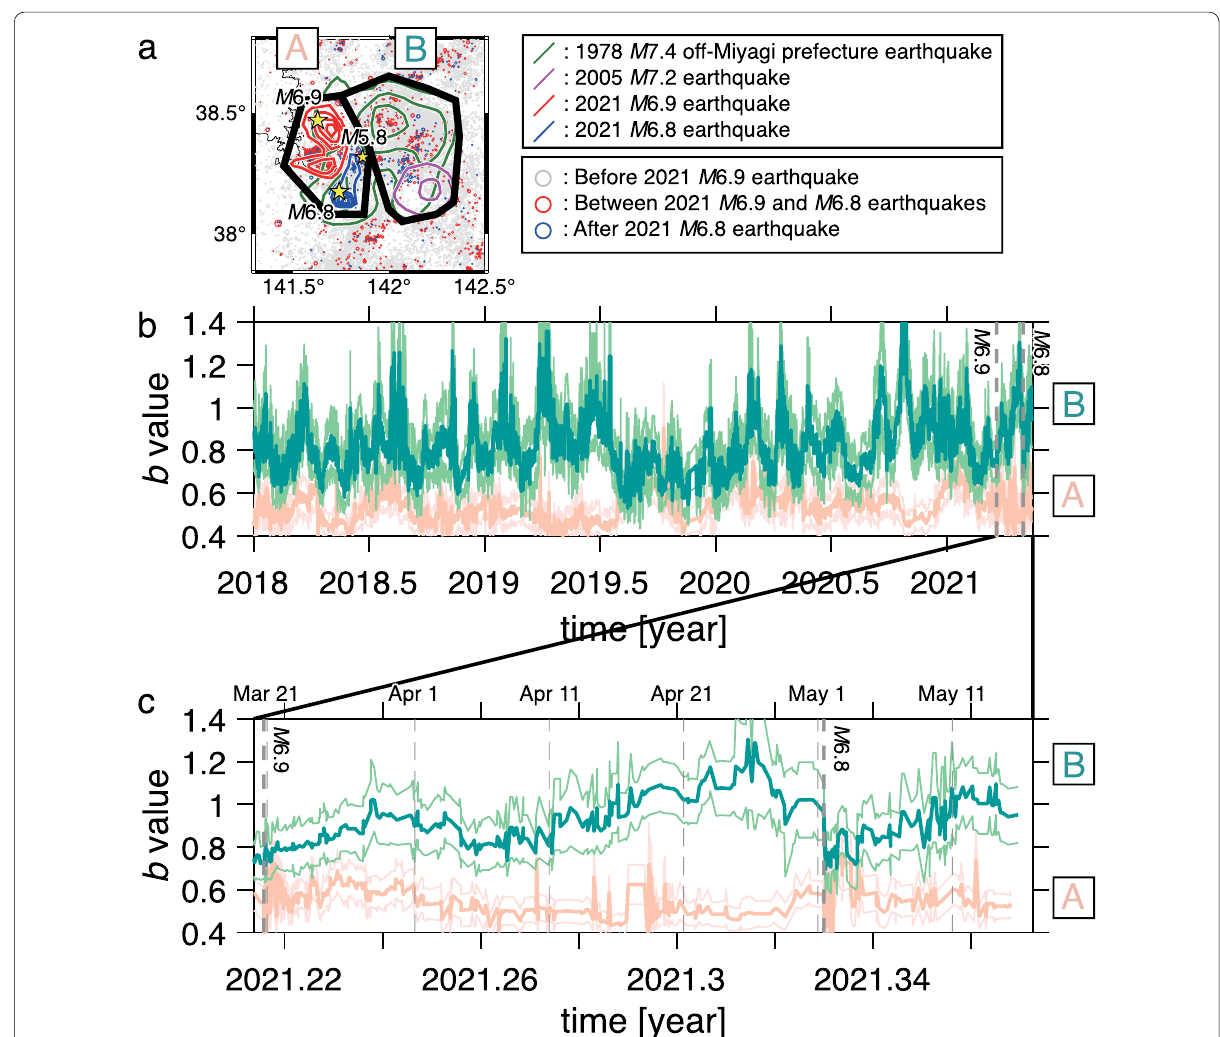
Fig. 5 Time series of b values. a Map showing the regions “A” and “B” considered in b , c . Stars indicate the epicenters of the M 6.9 March 20 earthquake, the M 5.8 April 18 earthquake, and the M 6.8 May 1 earthquake. Other symbols are the same as in Fig. 1. b Plot of b values as a function of time, as obtained from seismicity data along the plate boundary for the period since 2018. We used a moving window approach, whereby the window covered 100 events. The uncertainty estimates are according to Shi and Bolt (1982). Thick vertical dashed lines indicate moment of the M 6.9 and M 6.8 earthquakes. c Zoom-in figure for the period from immediately before the 2021 M 6.9 earthquake to May 15, 2021. Thin vertical dashed lines show March 21, April 1, 11, and 21, and May 1 and